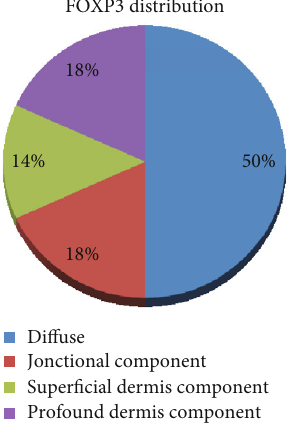
Figure 7: FOXP3 distribution within the